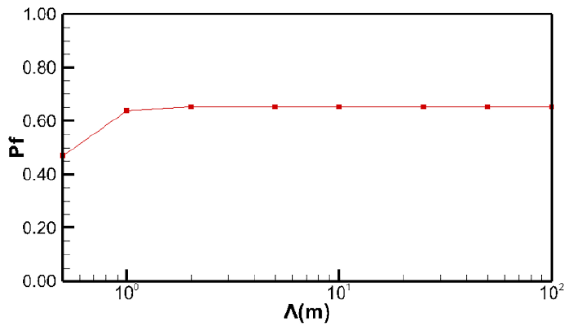
Figure 4. The change in p f with different correlation scales ( Λ = λ x = λ y ).